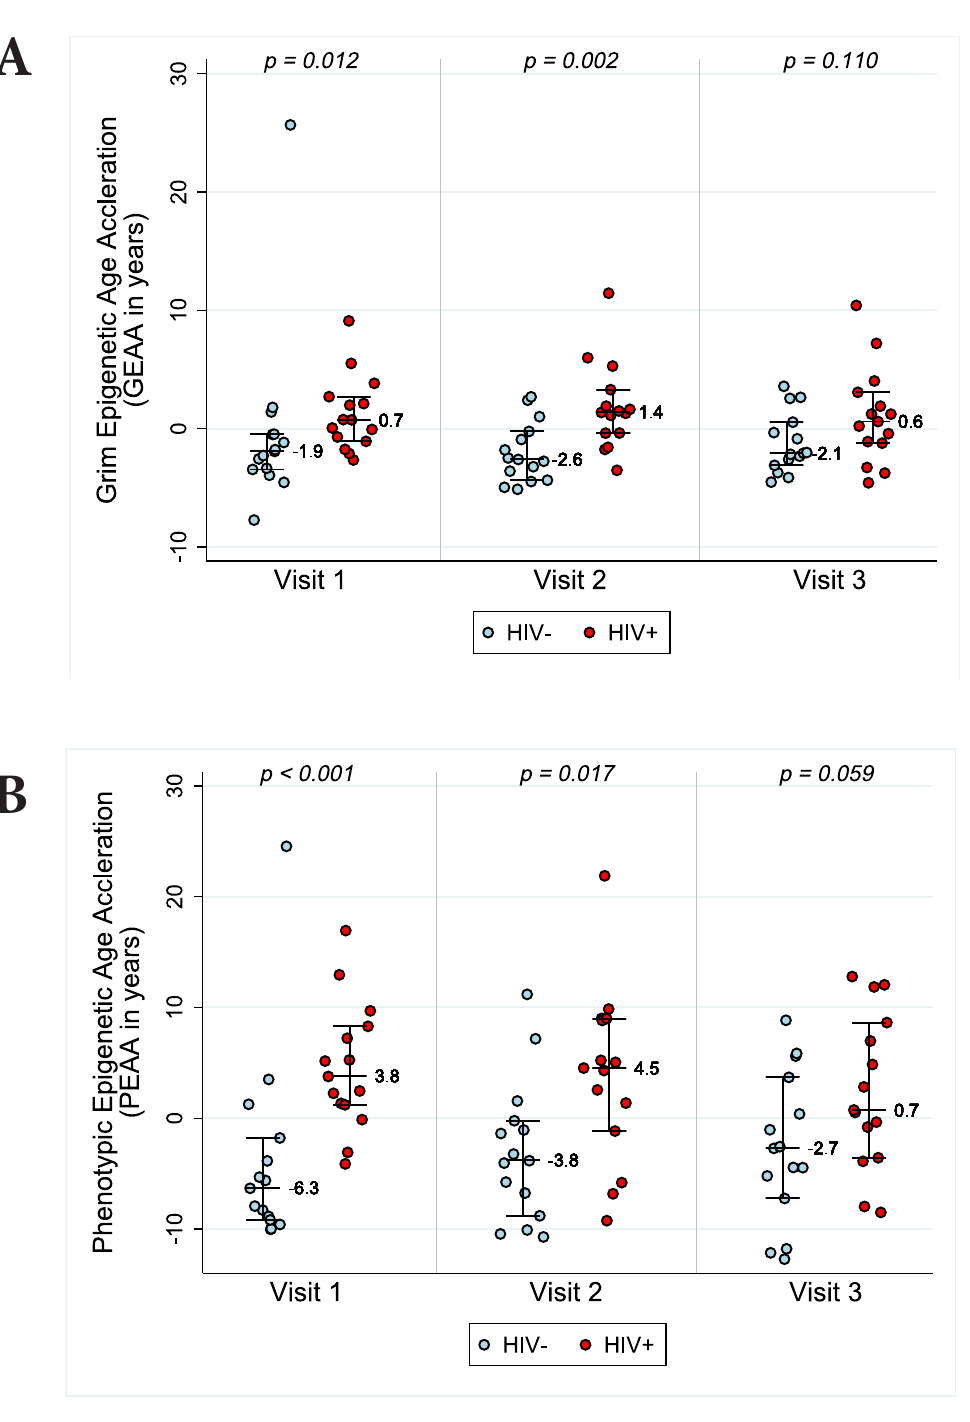
Figure 2A & B. Grim Age Acceleration (Panel A) and Phenotypic Age Acceleration (Panel B) for HIV- and HIV+ individuals before and after the initiation of ART. Data are shown for HIV- and HIV+ groups (n=15 per group) at the 3 Visits. Reported p values are a result of Wilcoxon rank sum tests between the two serostatus groups at the 3 time